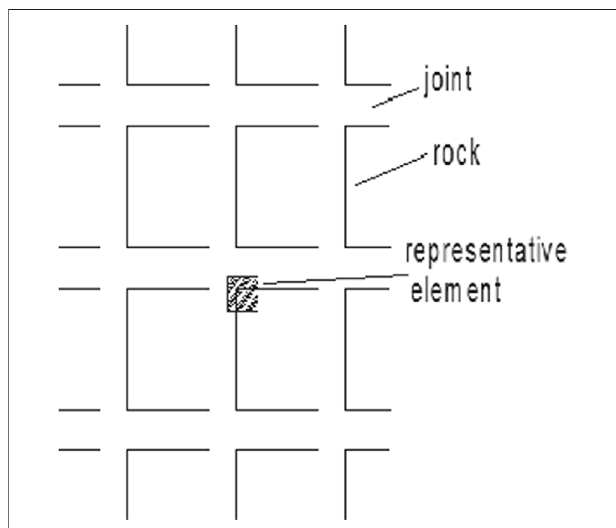
FIGURE 1 | Intact rock block cut by orthogonal joints (Yang and Wu, 1991).